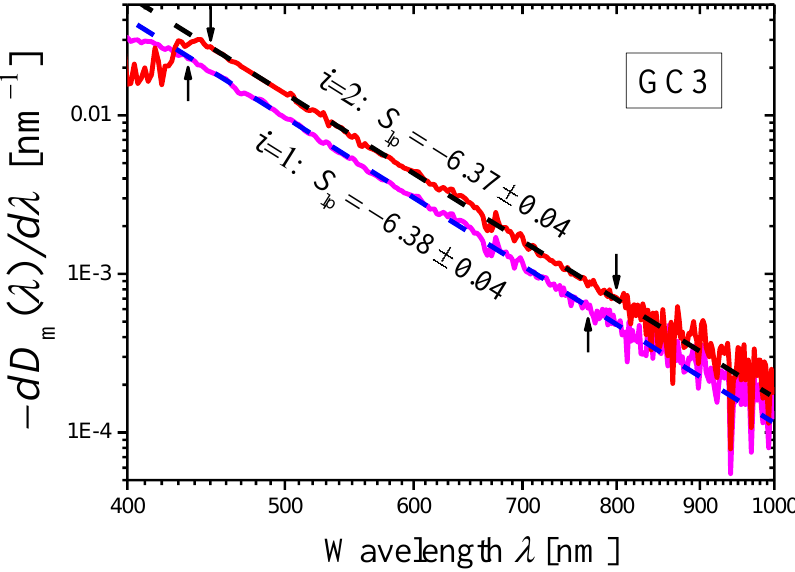
Figure 3. Log–log plots of the dependences of ( − dD i m ( λ ) / d λ ) on λ (curves) constructed for the Figure 3. Log – log plots of the dependences of (−𝑑𝐷 𝑖 m (𝜆)/𝑑𝜆) on 𝜆 (curves) constructed for the measured optical densities D i m ( λ )( i = 1,2 ) of two samples of the glass-ceramic GC3. The thicknesses measured optical densities 𝐷 𝑖 m (𝜆) (𝑖 = 1,2) of two samples of the glass-ceramic GC3. The of the samples are: h 1 = 2.11 mm (magenta curve) and h 2 = 3.02 mm (red curve). The portion of each thicknesses of the samples are: ℎ 1 = 2.11 mm (magenta curve) and ℎ 2 = 3.02 mm (red curve). The curve limited by arrows is approximated by a dashed straight line using the least squares method, and the slope S lp of the straight line is indicated in the